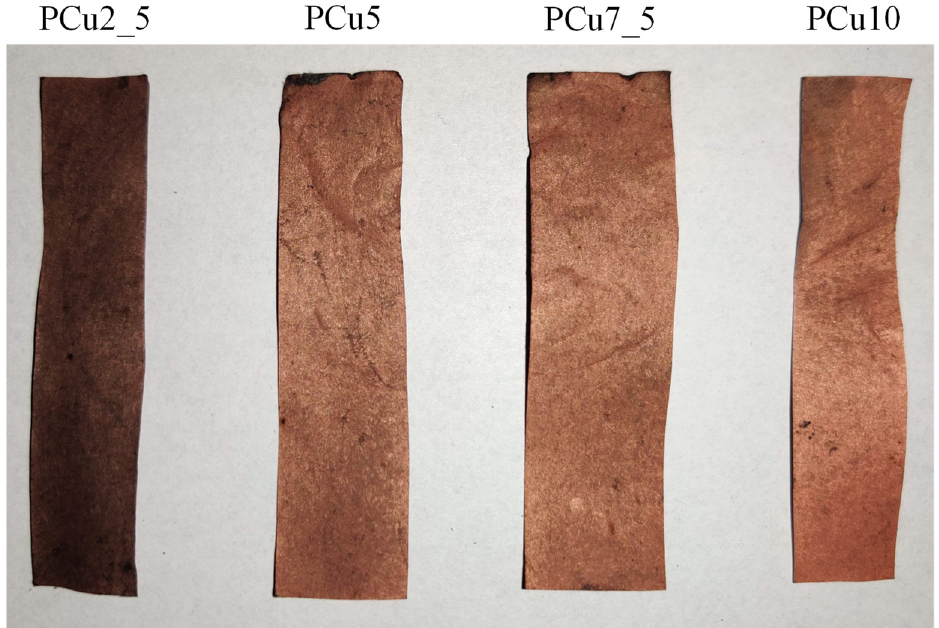
Figure 5. The effects of electroless copper plating of paper depending on the time of metallization